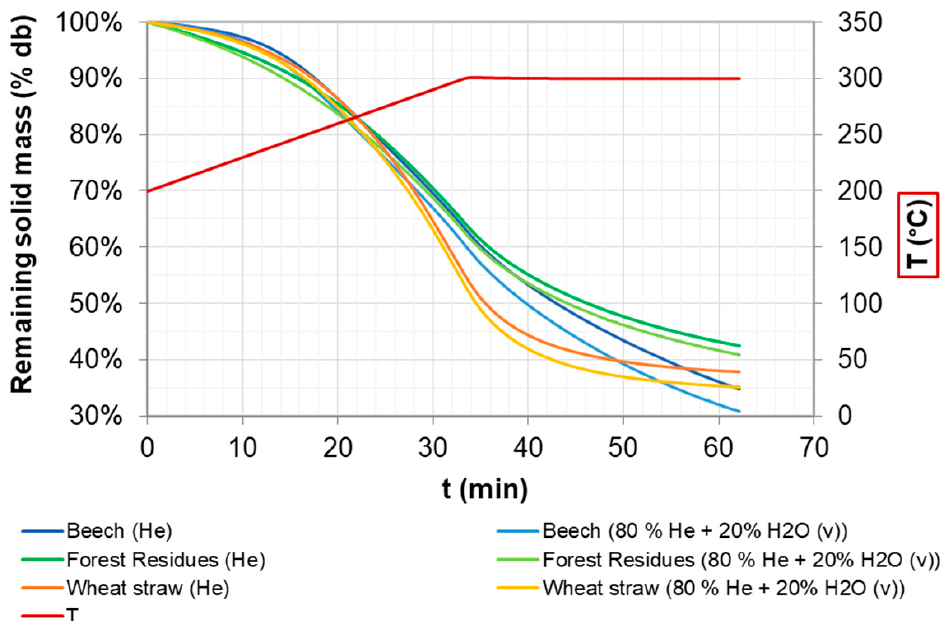
Figure 4. Remaining solid mass versus time and temperature obtained during torrefaction of beech, forest residues and wheat straw in a thermogravimetric analyzer (TGA) under dry (He, 100% v/v ) and moist (H 2 O/He, 20% v/v ) atmospheres.